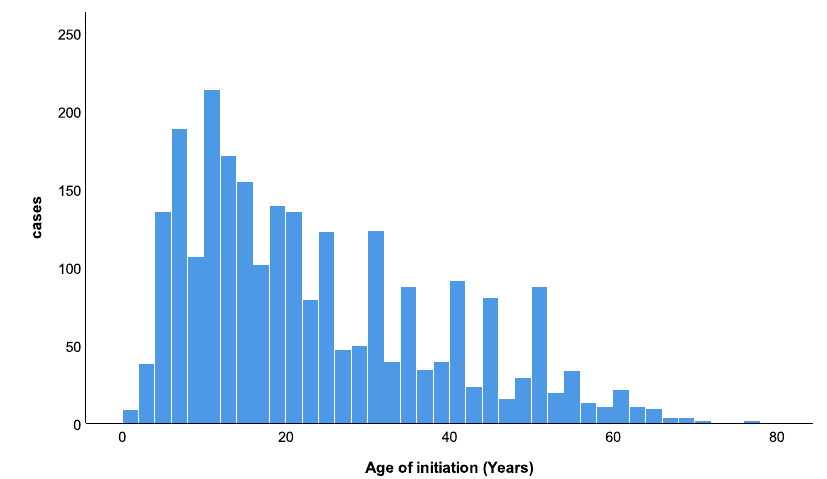
Fig. 1 Initiation age into birding. Mean age of the initiation into birding, number of cases according to age.